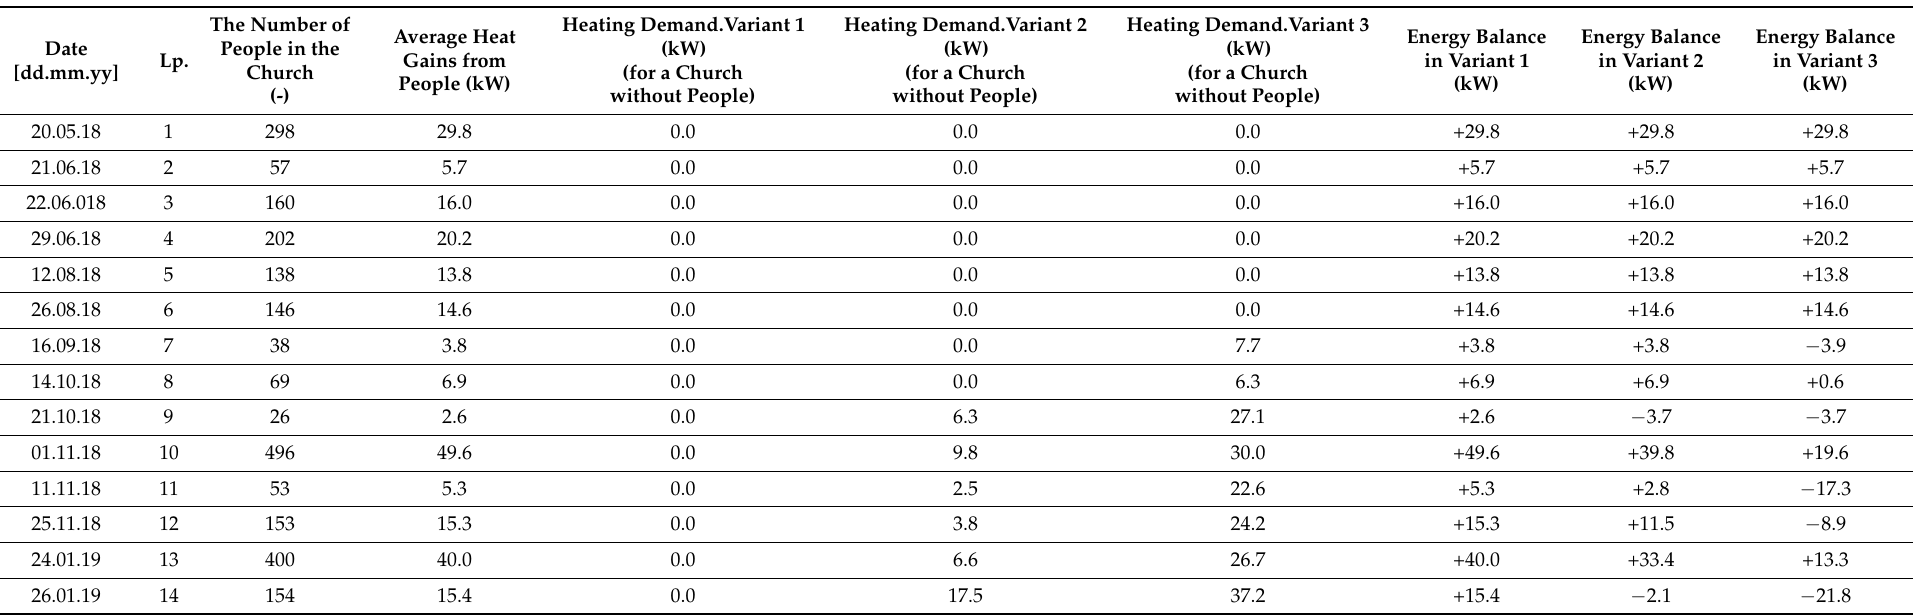
Table 3. Heating demand during